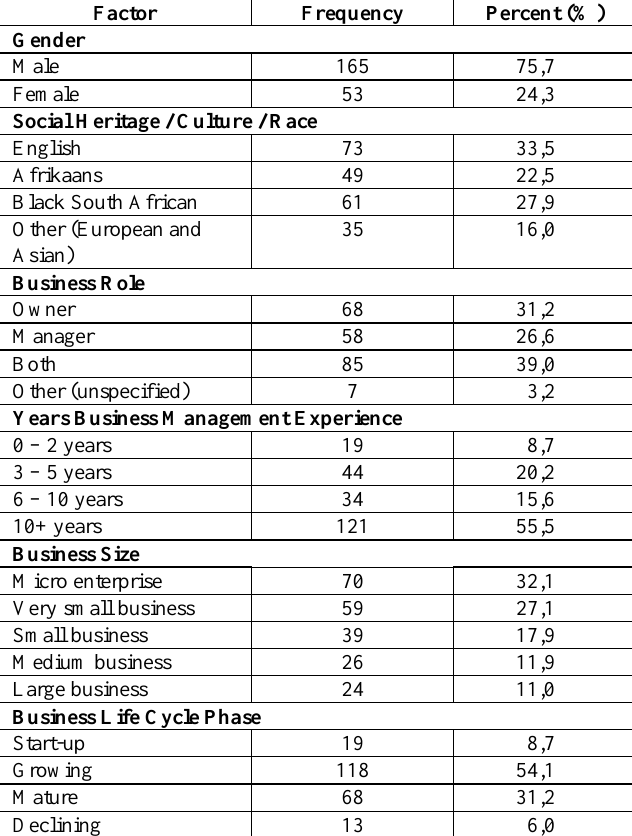
Table 1: Demographic information of the